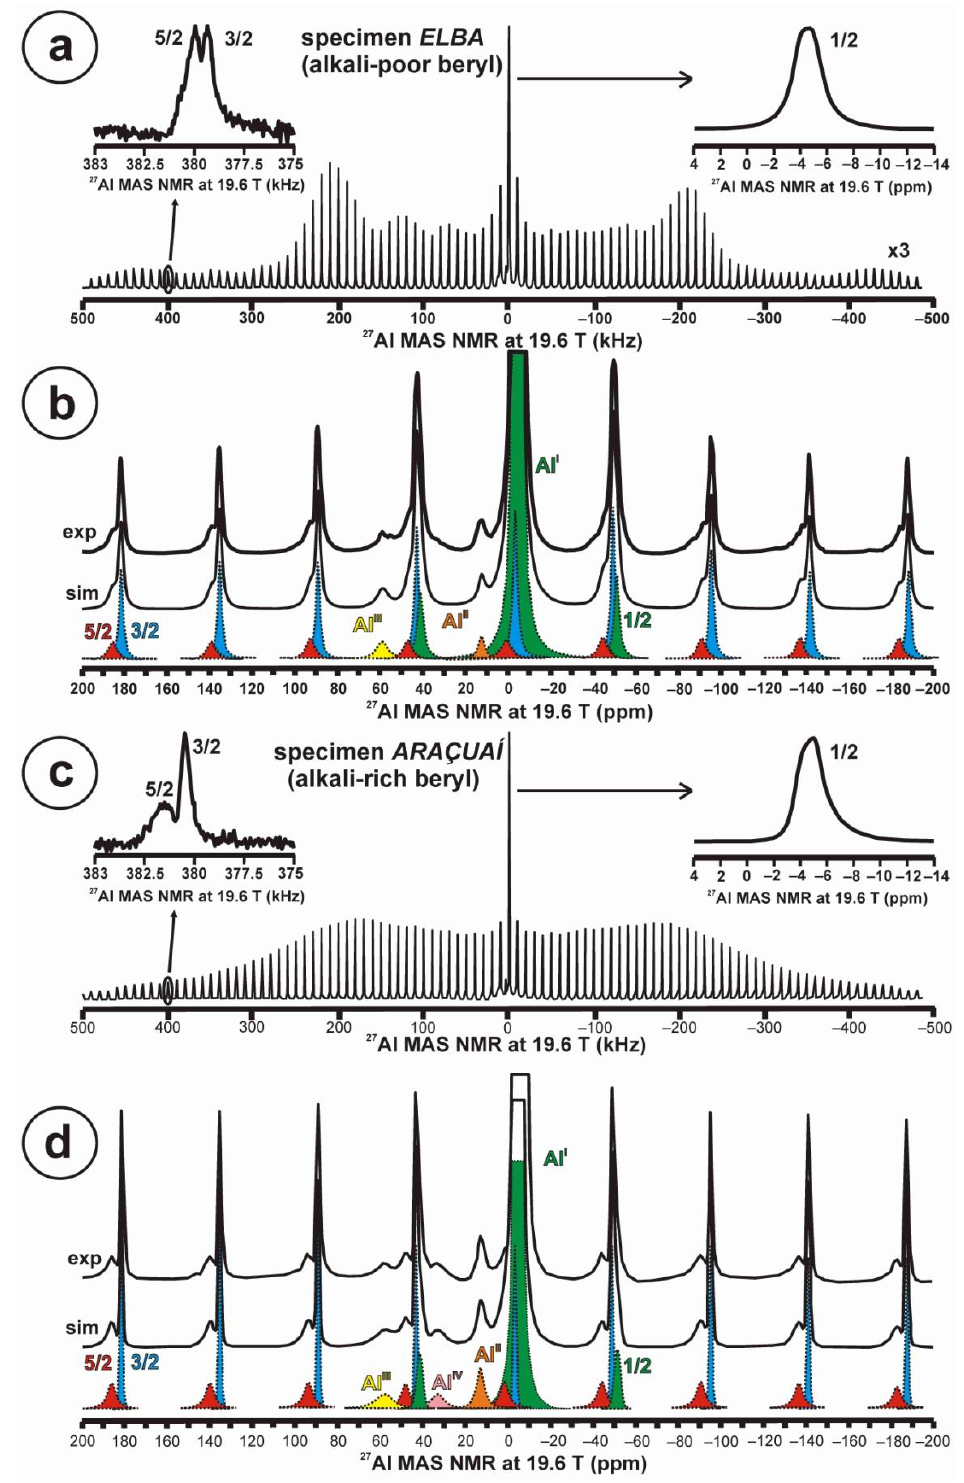
Figure 6. The 27 Al NMR MAS spectra at 19.6 T of beryl-group minerals. ( a , b ) Specimen Elba or alkali-poor beryl shows a well-developed quadrupolar shape in the STMAS profile, with the shape of the central transition 1/2 (green and inset up to the right) and the other two transitions 5/2 (red) and 3/2 (blue) in a satellite line as inset up to the left. Three Al sites, Al I , Al II and Al III , are resolved in ( b ). ( c , d ) Specimen Araçua í or alkali-rich beryl does not have a defined quadrupolar shape in the STMAS profile, with the same transitions and the same three Al sites, but also an additional Al IV site (see explanations in text). Experimental conditions: ν r = 10 kHz, using a 1.0 µ s excitation pulse, 4 mm rotor, recycling delay 5